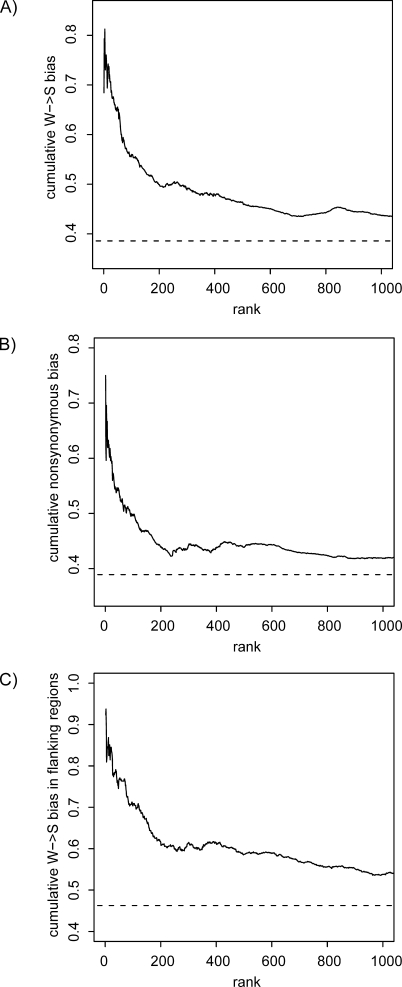
Cumulative Bias in Different Classes of Nucleotide Substitutions in the Exons with the Highest Degree of Acceleration on the Human Lineage(A) The proportion of W→S substitutions compared to W→S and S→W substitutions on the human lineage.(B) The proportion of nonsynonymous substitutions compared to all substitutions in each gene on the human lineage.(C) The proportion of W→S substitutions compared to W→S and S→W substitutions on the human lineage in the flanking noncoding regions.Dashed lines represent averages for the entire dataset.